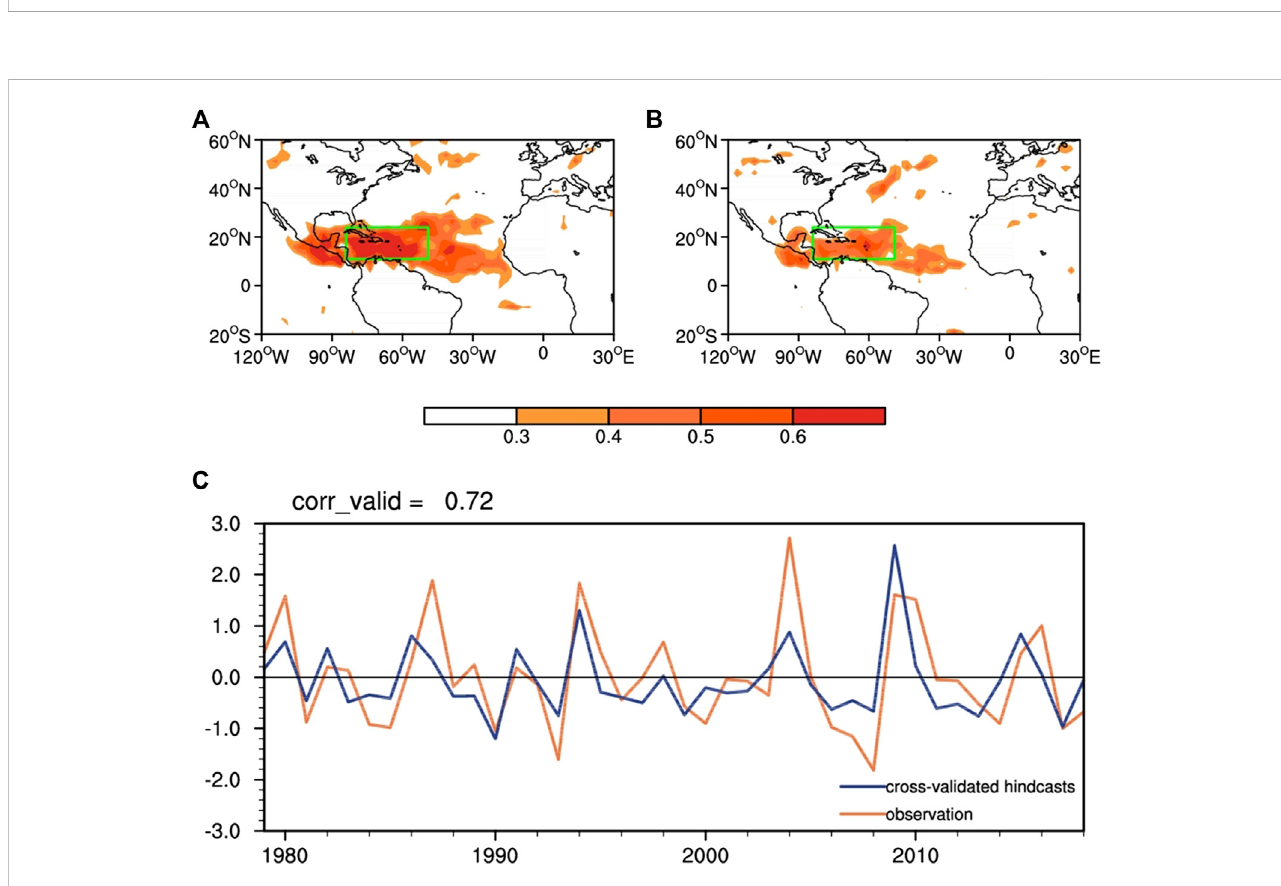
FIGURE 15 (A) Correlation between the observed and hindcast JJA (+1) precipitation anomalies obtained from the empirical prediction model. (B) Correlation between observations and fourfold cross-validated hindcasts of JJA (+1) precipitation anomalies. Only areas with correlations signi fi cant at the 90% level are shown. (C) Time series of observed and fourfold cross-validated hindcast JJA (+1)